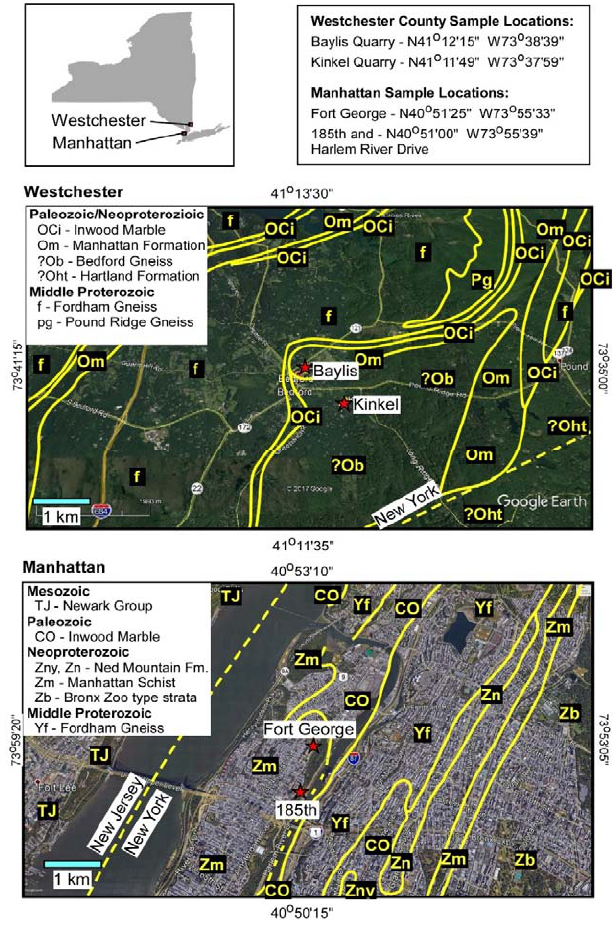
Figure 1. Location diagram, geological contacts, and sample locations for this study. The inset shows the location of the study area with respect to New York